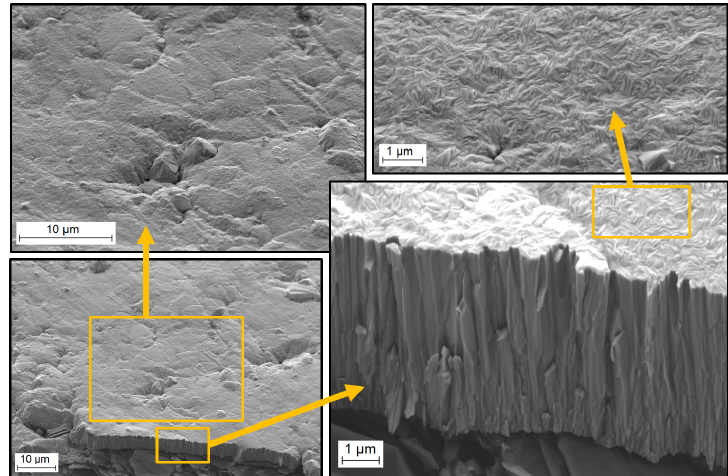
Figure 25. SEM observations of a Mo-coated MoGr sample produced with HIPIMS. The fracture surface ( bottom ) and the coating surface ( top ) are